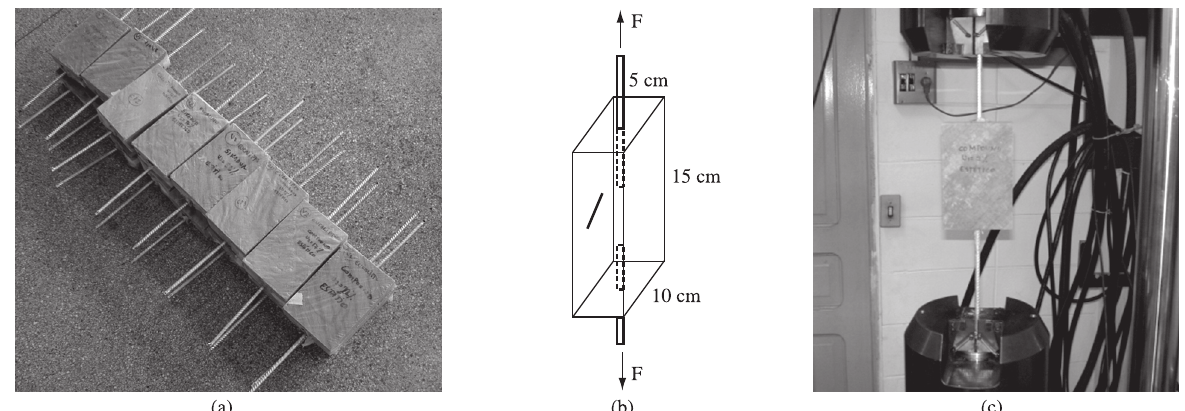
Figure 2. Fatigue and static tests: a) Test specimens with bonded-in rod; b) Test configuration; c) Test in progress – DARTEC